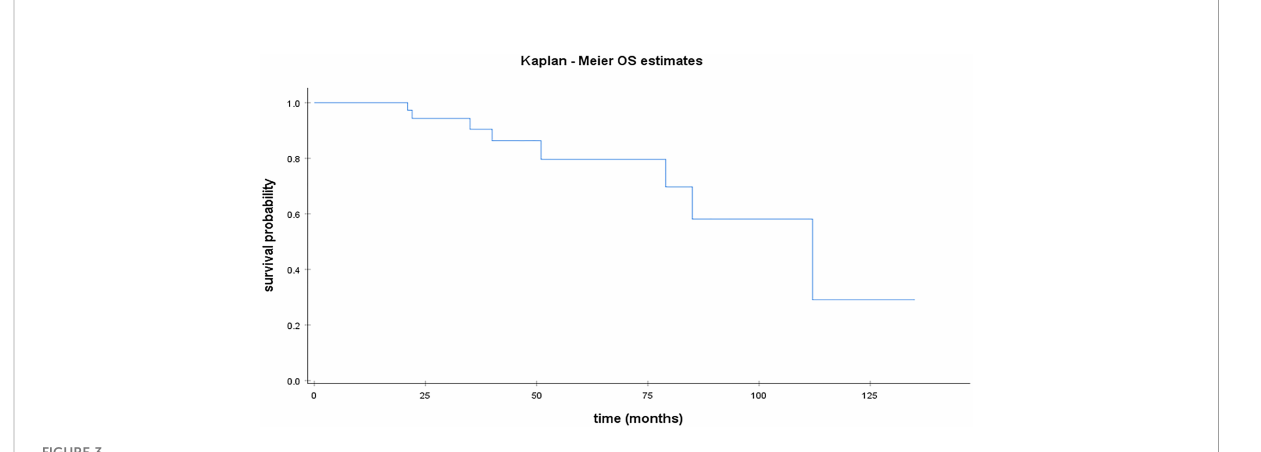
FIGURE 3 Kaplan Meier curve for PFS in